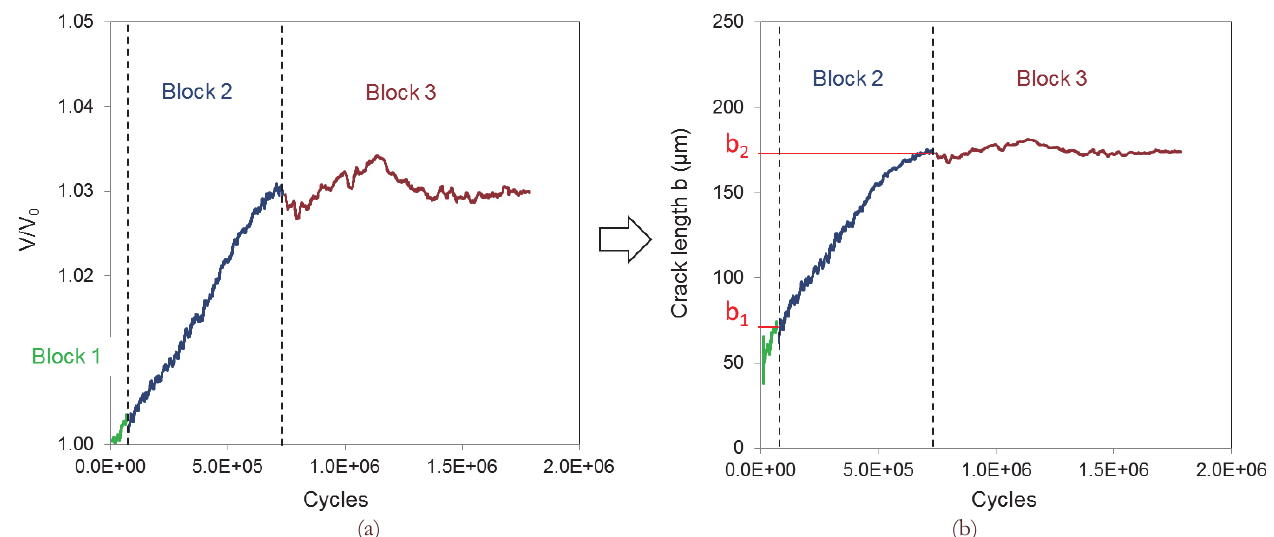
Figure 9: (a) Potential evolution during mixed load test, (b) Crack propagation rate established with the calibration